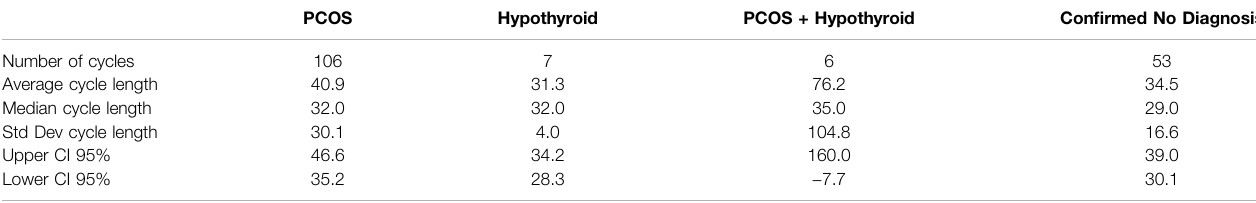
TABLE 2 | Cycle comparison by prior diagnosis